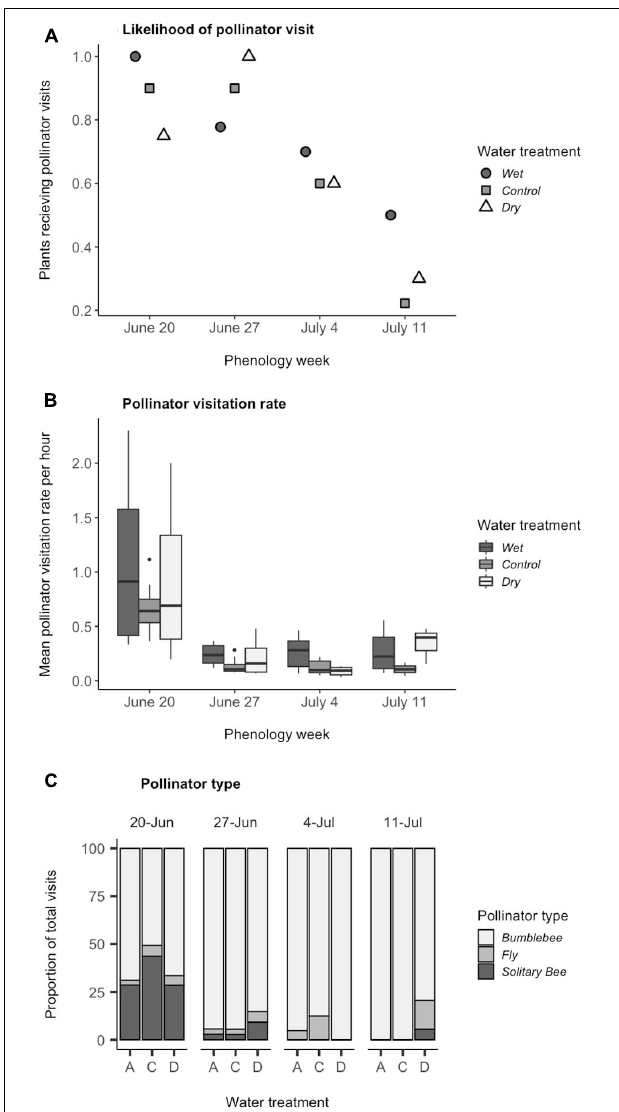
FIGURE 4 | Effects of experimental variation in soil moisture and flowering phenology on visitation. (A) The likelihood that a plant received a pollinator visit. Wet differed from control (Tukey pairwise comparison among water treatments, P < 0.0001). Week 1 differed from weeks 3 and 4 (Tukey pairwise comparison among phenology weeks, P < 0.0001). (B) The mean pollinator visitation rate per plant among plants that received at least one visit, calculated as (total number of flowers visited/number of flowers available per hour of observation) averaged across the phenology week. Wet differed from control ( P < 0.010). Week 1 differed from all other weeks ( P < 0.001). (C) The percent of total pollinator visits that were comprised of bumblebees, flies, and solitary bees ( N = 114). Significant interaction terms ( P < 0.05) were: week 1 vs. 2 in control vs. dry treatment, week 1 vs. 2 in wet vs. dry treatment, and week 1 vs. 4 in control vs. dry treatment. Boxplots follow the same conventions as in Figure 1